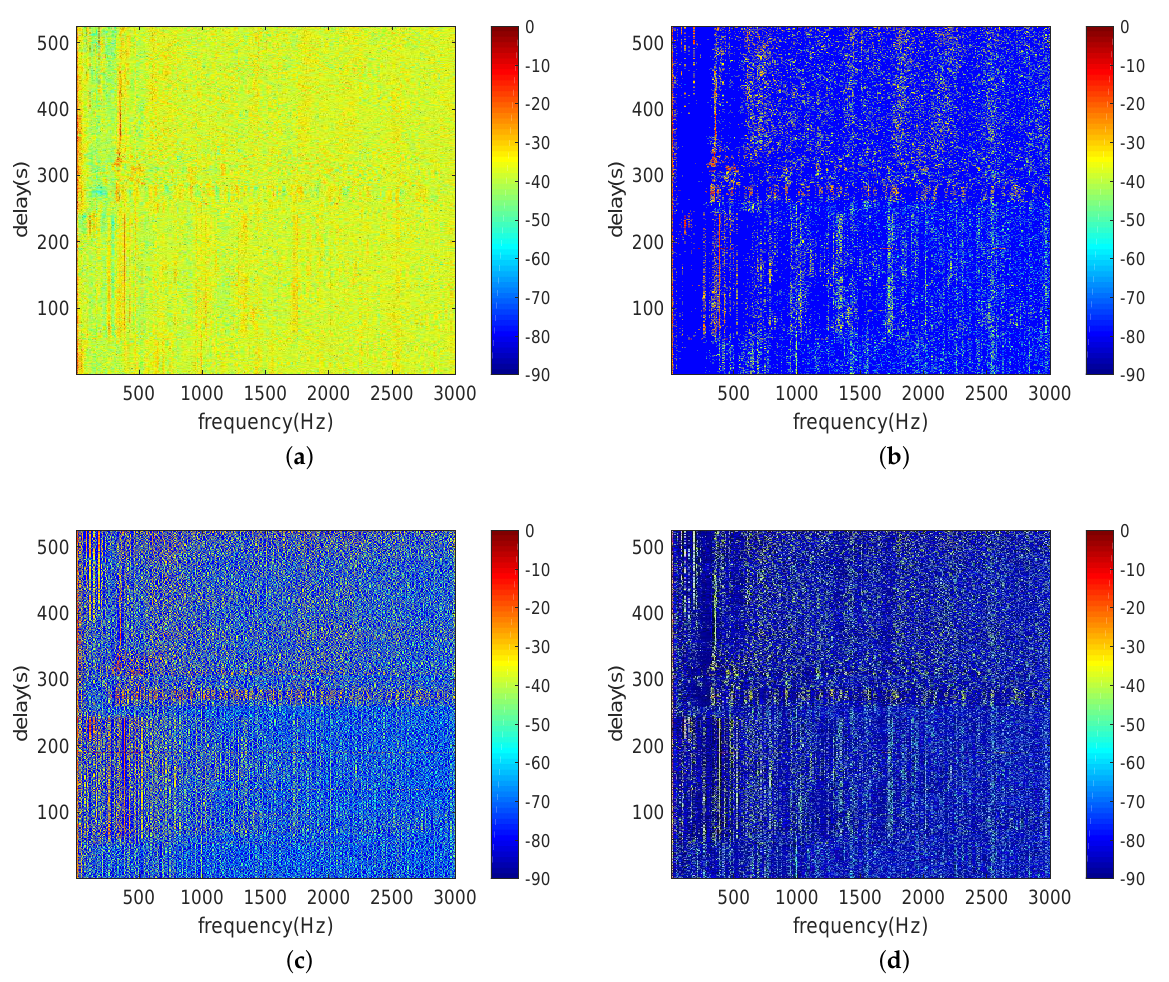
Figure 5. Normalization results of ( a ) TPSW; ( b ) OTA; ( c ) beam characteristics scan; and ( d ) our proposed approach. (the unit of colorbar is